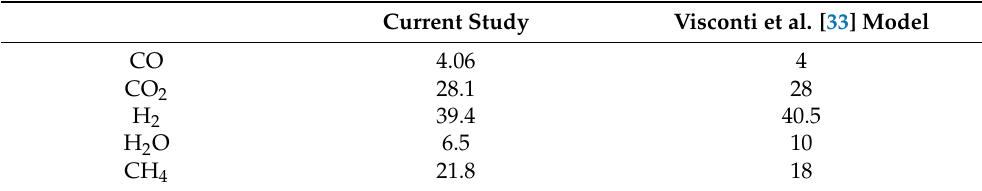
Table 6. Comparison of components (mol%) in syngas.